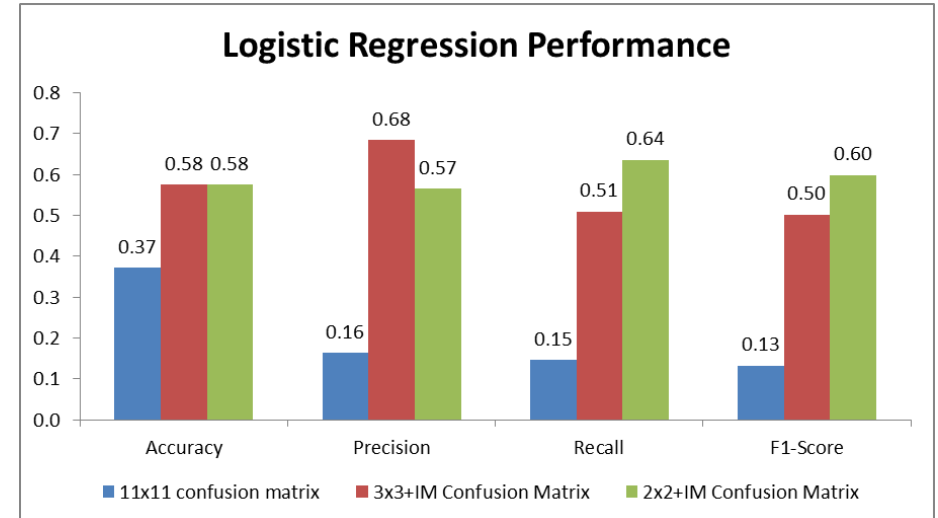
Figure 8. Logistic regression performance for the original and reduced confusion matrices.